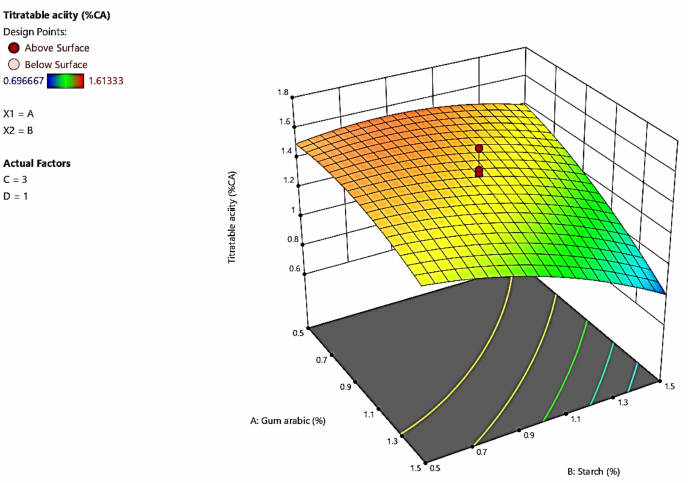
Figure 4. Response surface plot for titratable acidity (% CA) of coated “Wonderful” pomegranate as a function of gum arabic and maize starch and